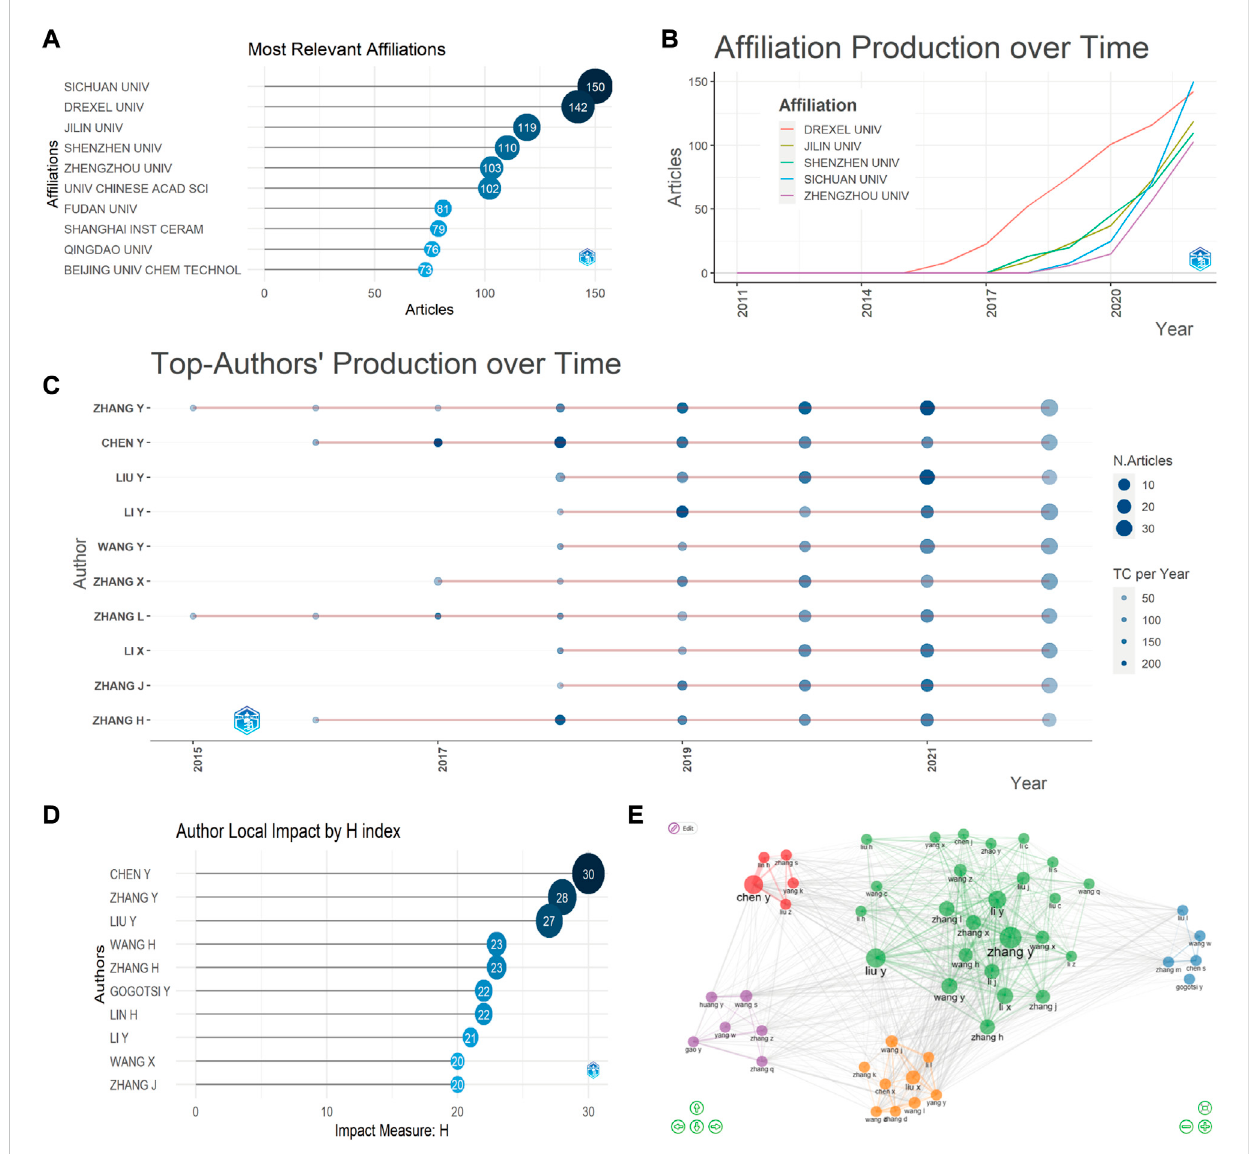
FIGURE 3 Imagenetworkofinstitutesandauthor. (A) Documentsissuedbyactiveinstitutions, (B) Numberofdocumentsissuedbyactiveinstitutionsovertime, (C) Over time, the production of top authors dedicated to MXene medical applicatio. (D) H index sorting results of top writers. (E) Visualization network map of cooperation among